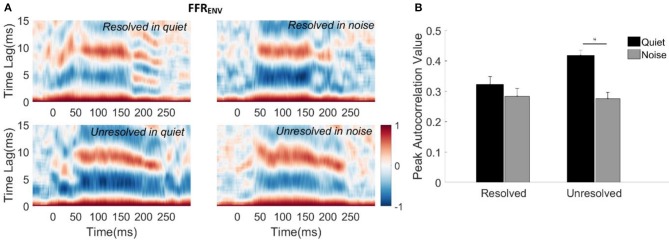
(A) Autocorrelograms of grand average FFRENV waveforms for each stimulus condition. The horizontal axis represents the midpoint in each 30 ms time bin, the vertical axis represents the time lags between the time windowed signal with its copy signal, and the color represents the strength of correlation (red is maximum). (B) The peak autocorrelation value averaged across participants for each stimulus condition. The black bars represent the stimulus in the quiet condition, and gray bars represent the stimulus in noise condition. Error bars represent one standard error. The significant difference of p < 0.001 is indicated by the asterisk.